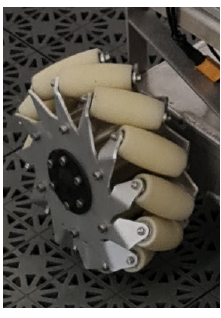
Figure 6. A mecanum wheel used on the ACS.